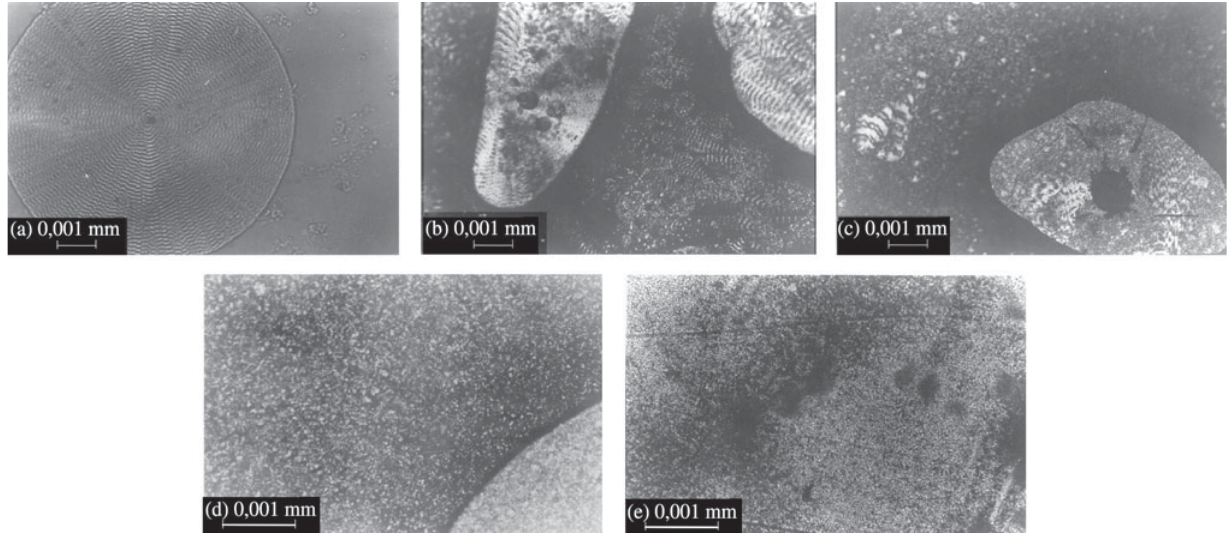
Figura 11. Micrografias de PLM com luz polarizada das blendas de P(3-HB)/PCL e dos homopolímeros: a) P(3-HB); b) P(3-HB)/PCL (80/20); c) P(3-HB)/PCL (50/50); d) P(3-HB)/PCL (20/80); e) PCL.